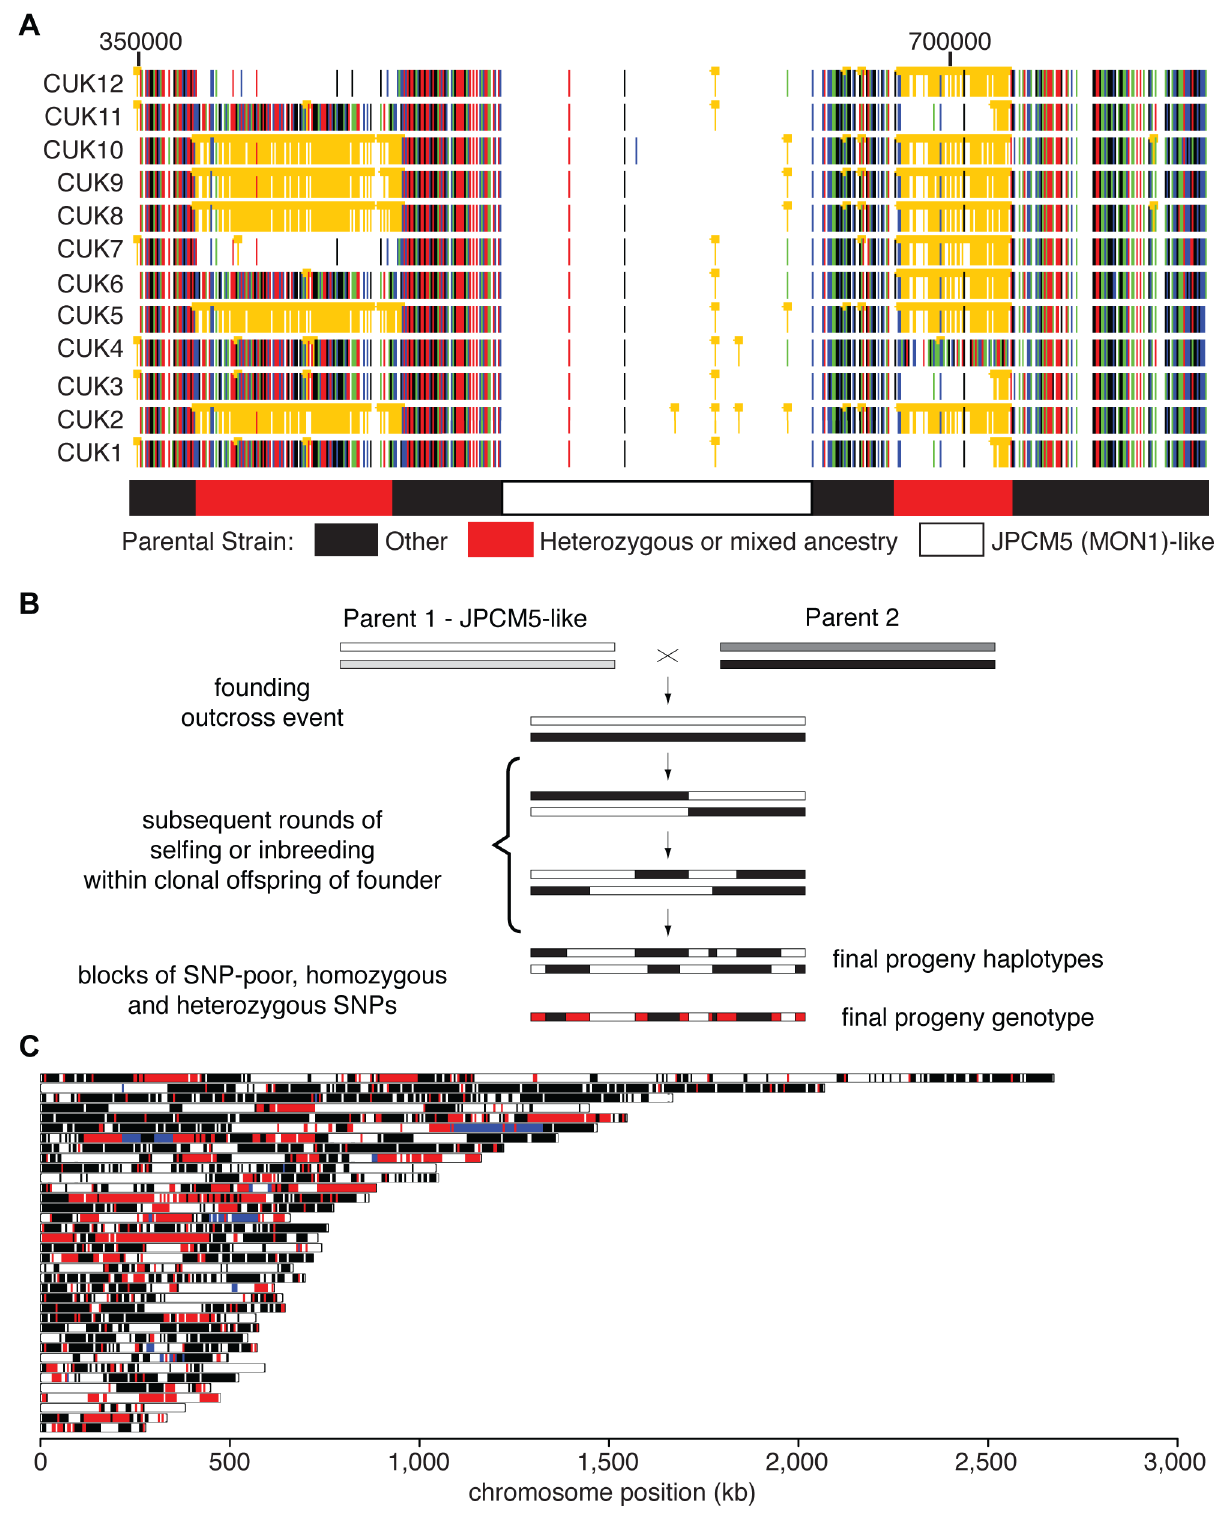
Figure 1. Genome-wide patterns of polymorphism and divergence show patchy heterozygosity symptomatic of hybrid ancestry. (A) Plot of single-nucleotide polymorphisms (SNPs) with respect to L. infantum JCPM5 in a section of chromosome 28 across the 12 strains. Orange ‘blocked’ bars indicate heterozygous positions; green, red, blue and black indicate homozygous variant calls of A, C, G and T respectively. Regions derived from one or both parental strains are shown in the block diagram below. CUK strain numbers (left) and chromosomal position (above, nucleotides) are as indicated. (B). Schematic of putative hybridization/inbreeding model, illustrating how a single hybridization event followed by crossing within the offspring could result in patchy heterozygosity in the progeny sampled here. (C) Parentage blocks inferred from mixture model